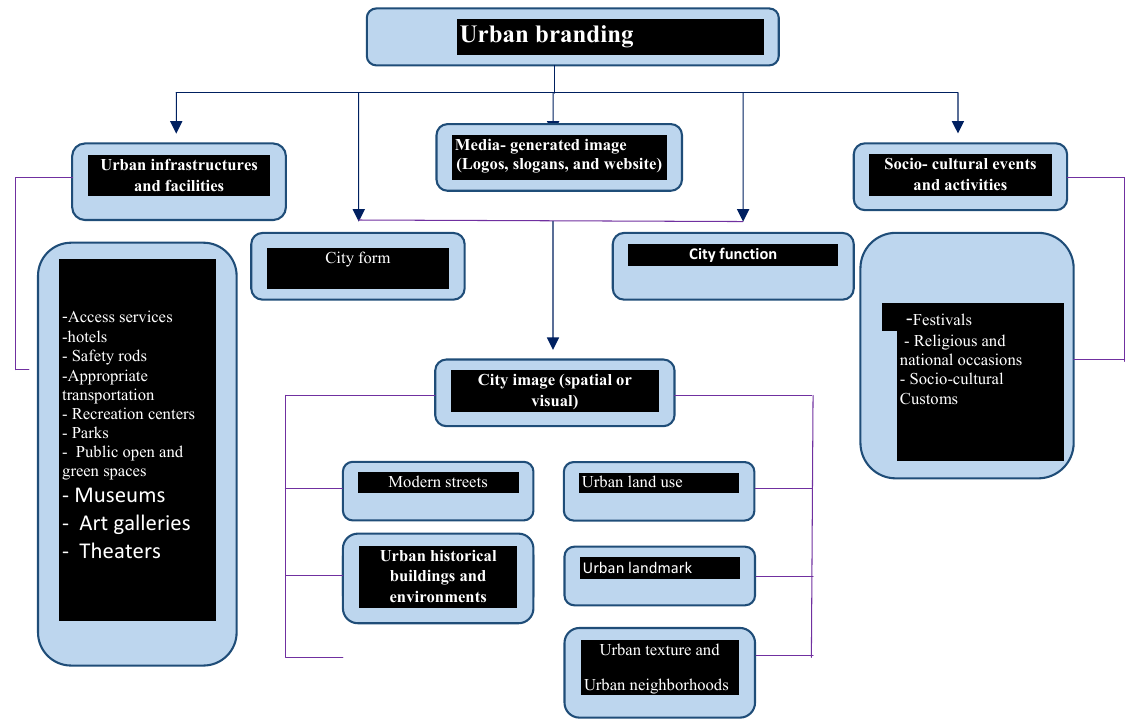
Fig. 2. The components of urban branding Fig. 2 : The components of urban branding (authors)